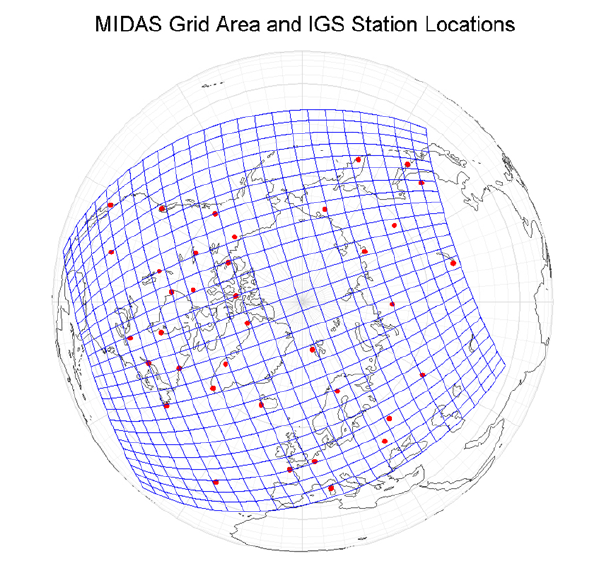
Fig. 1. MIDAS grid area with internal latitude and longitude divi- sions shown (blue). Red dots show the locations of IGS receiver stations, data from which are incorporated in the MIDAS